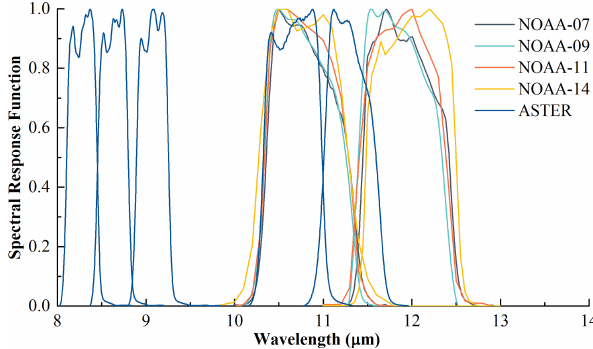
Figure 1. Spectral response functions of NOAA-07, 09, 11, and 14 AVHRR and Terra